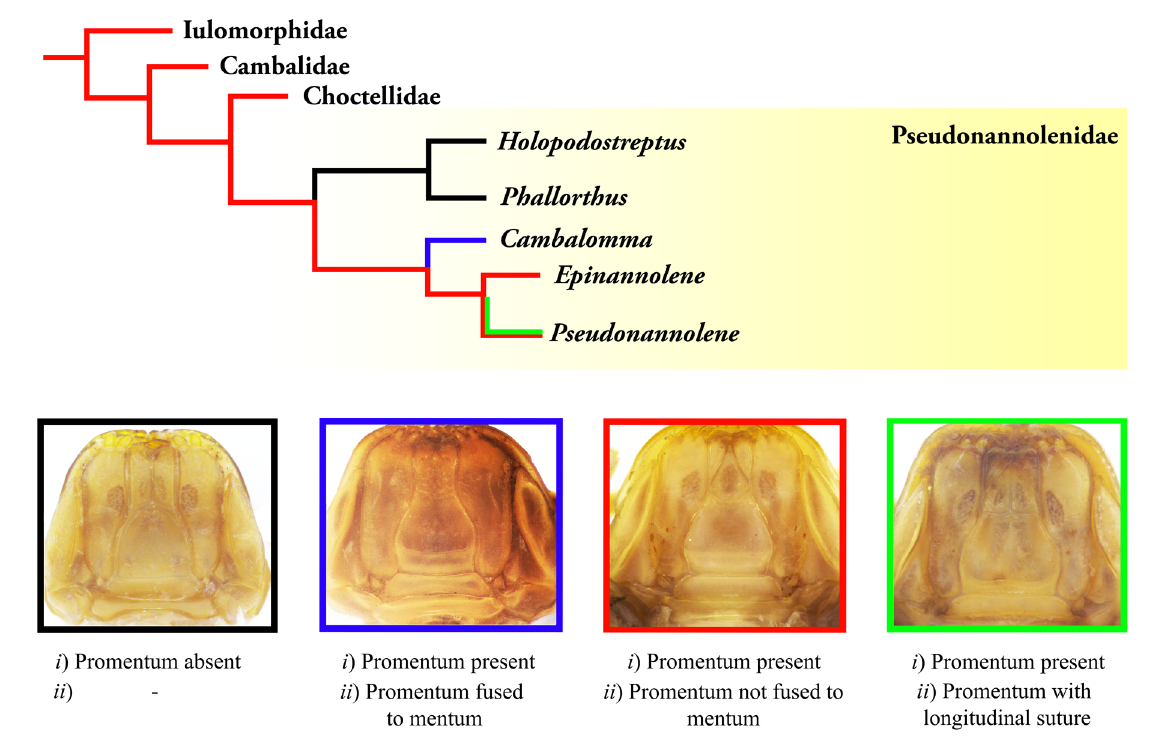
Fig. 10. Morphology of gnathochilarium based on the tree topology summarized under implied weighting ( k = 4–7). Images of gnathochilarium: black = Holopodostreptus braueri Carl, 1918 (MNRJ); blue = Cambalomma laevis Loomis, 1941 (MCZ); red = Epinannolene sp. (ICN); green = Pseudonannolene maritima Schubart, 1949 (IBSP